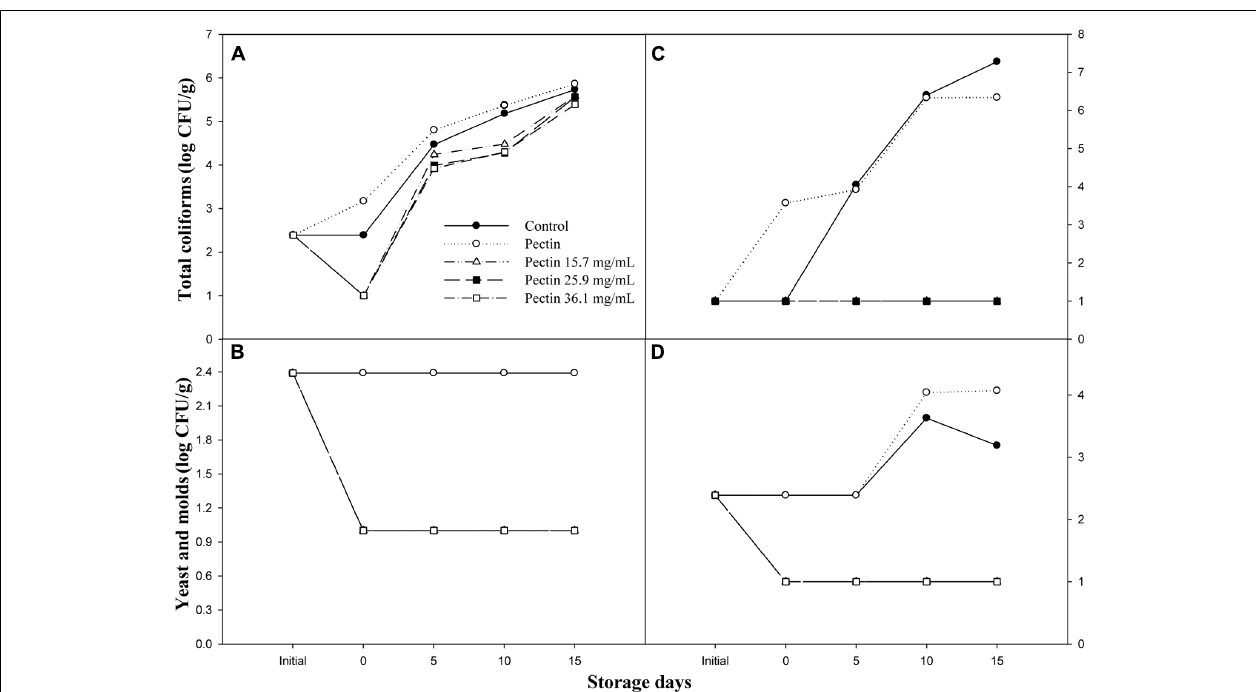
FIGURE 3 | Effect of OEO on the microbial load (log CFU/g), (A) total coliforms and (B) yeast and molds in shrimp; (C) total coliforms and (D) yeast and molds in sliced cucumber throughout 15 days of storage at 4 ◦